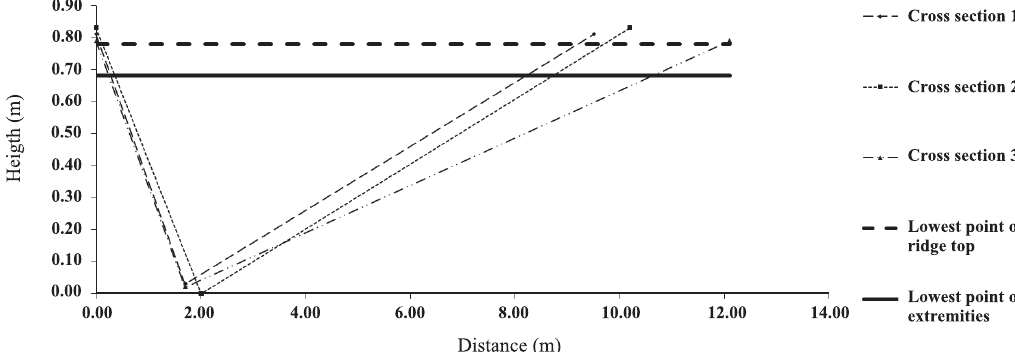
figure 6. cross section profile of the channel of terrace 2.